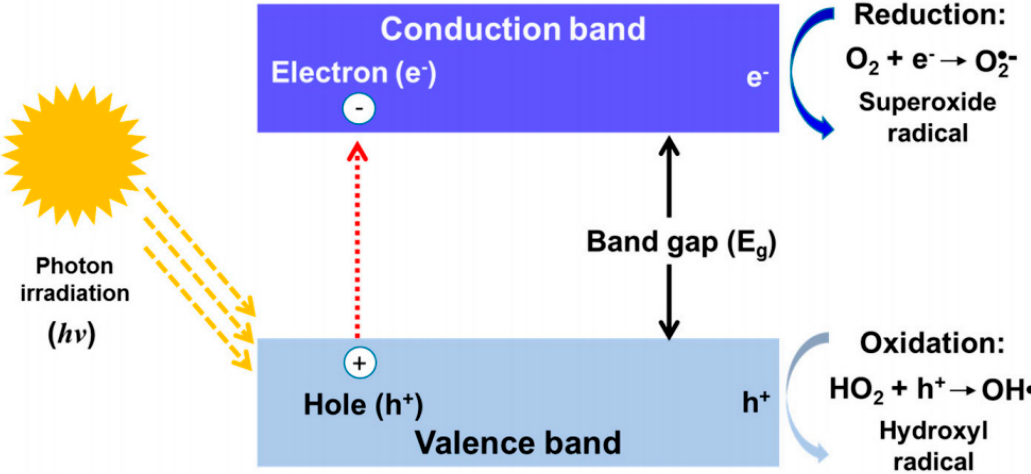
Figure 3. Excitation of an electron in a structure of photocatalyst and subsequent creation of ROS. Adapted from [48], with permission from Elsevier, 2018.